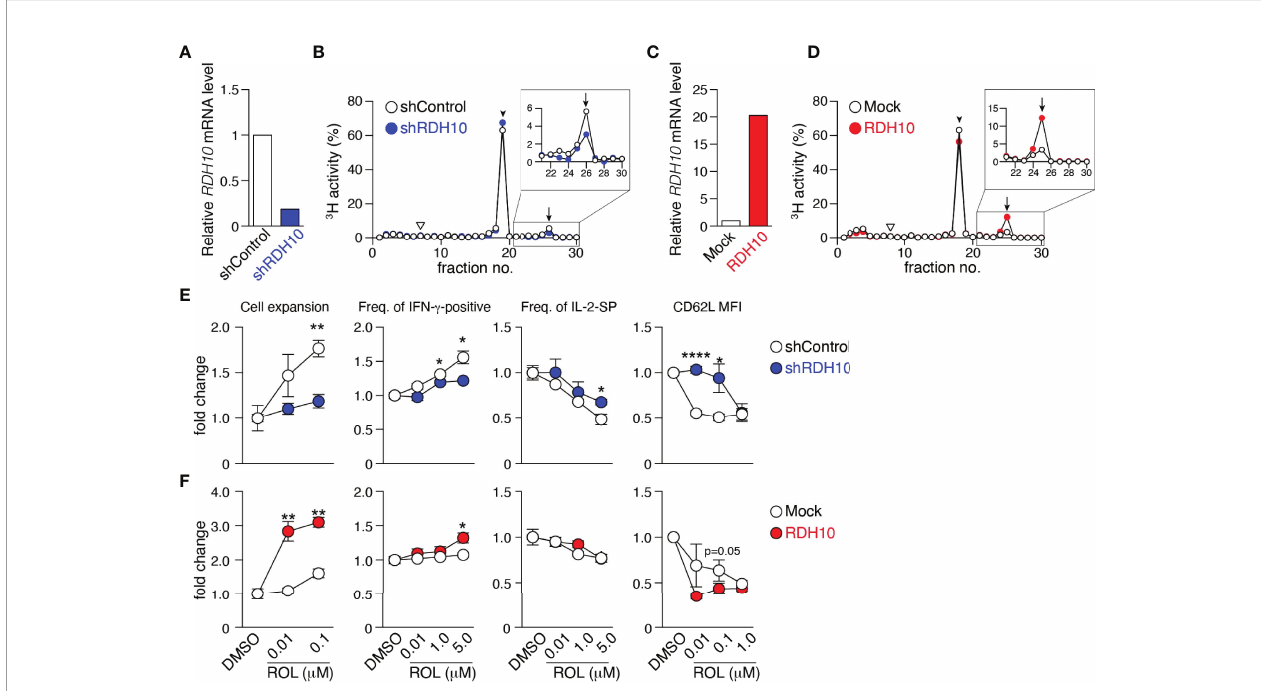
FIGURE 1 | RDH10 metabolizes vitamin A and regulates T cell differentiation. RDH10 in human CD4 + T cells was lentivirally knocked down (A, B, E) or overexpressed (C, D, F) . (A, C) RDH10 mRNA expression level. (B, D) shRDH10- (B) or RDH10 (D) -transduced T cells were cultured in the presence of [ 3 H]-all-trans ROL for 4 h. Then, cell extracts were fractionated by HPLC and the radioactivity of each fraction was measured. Arrowhead, arrow, and inverted triangle indicate the peak fraction of standard all-trans ROL, RAL, and RA, respectively. Representative results from two independent experiments are shown. (E, F) shRDH10- (E) or RDH10 (F) -transduced T cells were cultured in the presence of anti-CD3/28 mAbs, IL-2, and all-trans ROL (or DMSO) for 7 days, and then the cell number, cytokine-producing capacity in response to PMA/Ionomycin, and expression level of CD62L were measured. Data from three (cell number and cytokine-producing capacity) or fi ve (CD62L expression) independent experiments were analyzed by unpaired t-tests. Error bars show s.e.m. *p < 0.05; **p < 0.01; ****p <